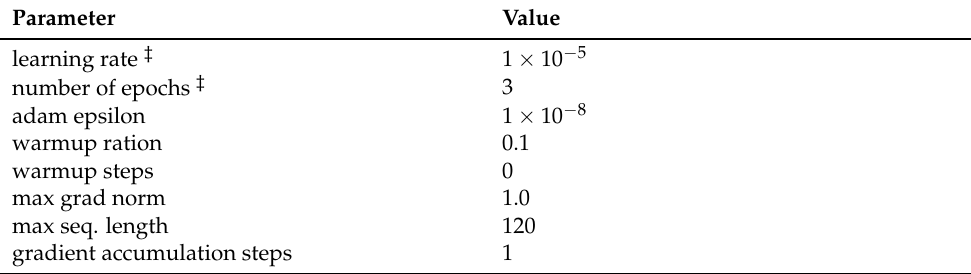
Table 2. Hyperparameter